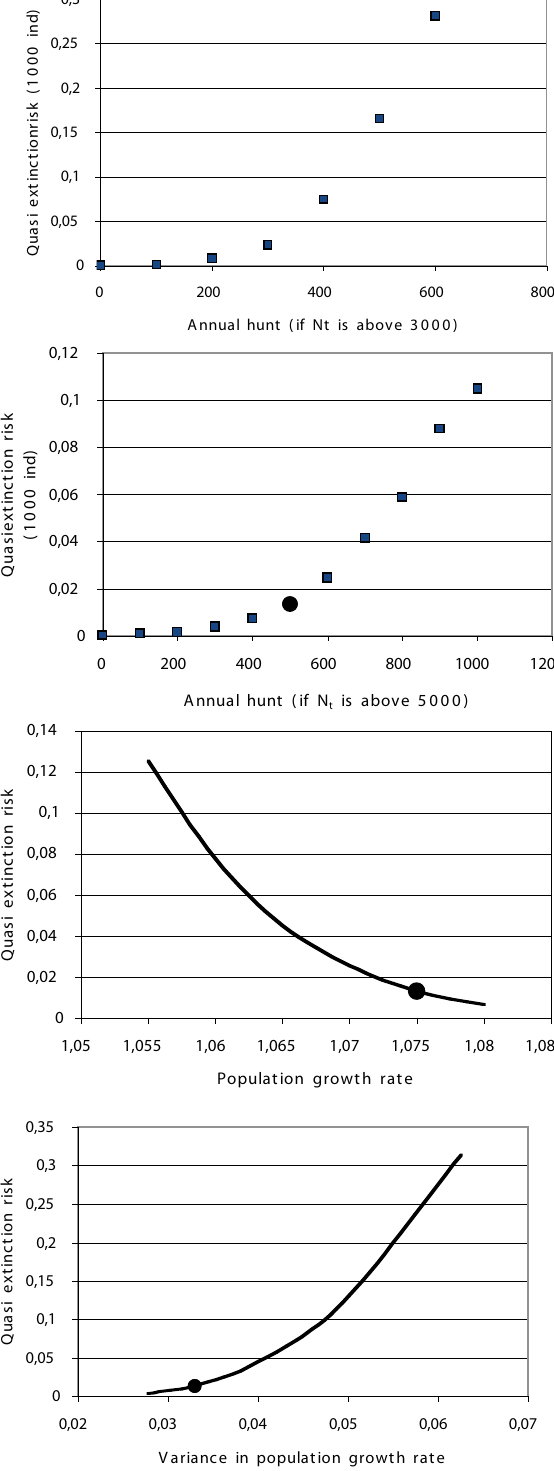
Fig. 12d. Slight changes in the variance of the mean growth rate leads to large increases in quasi-extinc - tion risk. Here the security level is kept at 5,000 females and the annual hunt is 500. The black dot refers to the variance 0.033, as found for the Baltic grey seal and is a reference point also indicated in Figs 12b, c and